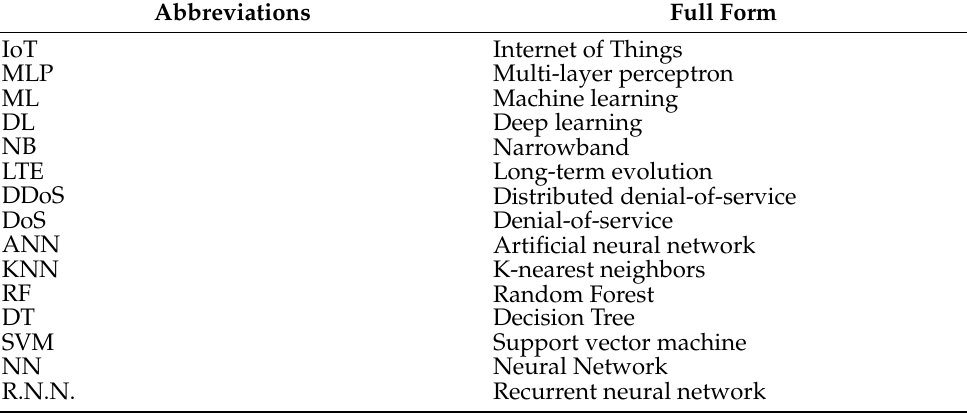
Table 1. List of